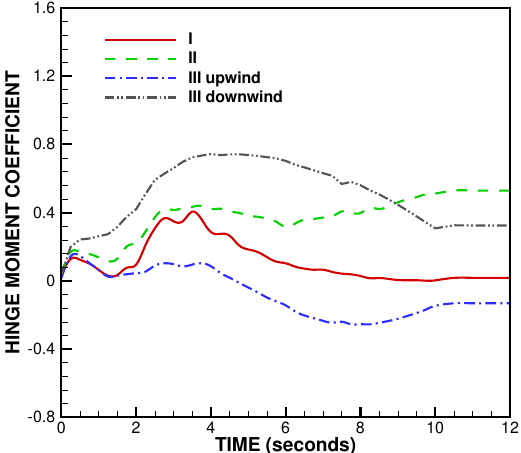
Figure 19. MLG: time history of hinge moment coefficient for the doors.